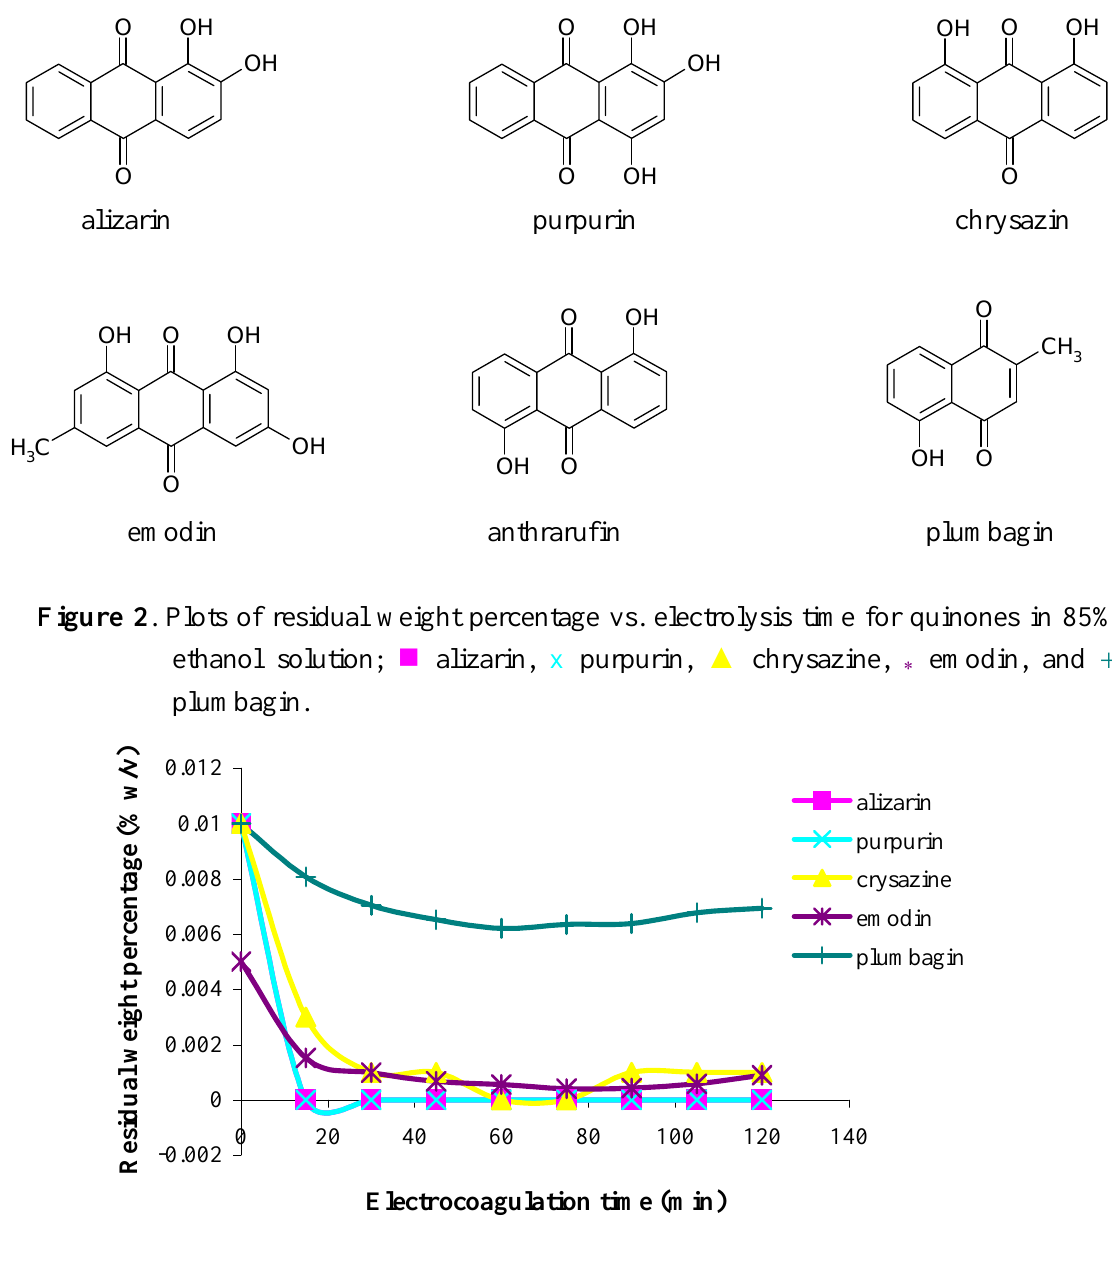
Figure 1 . Structures of the quinones studied.